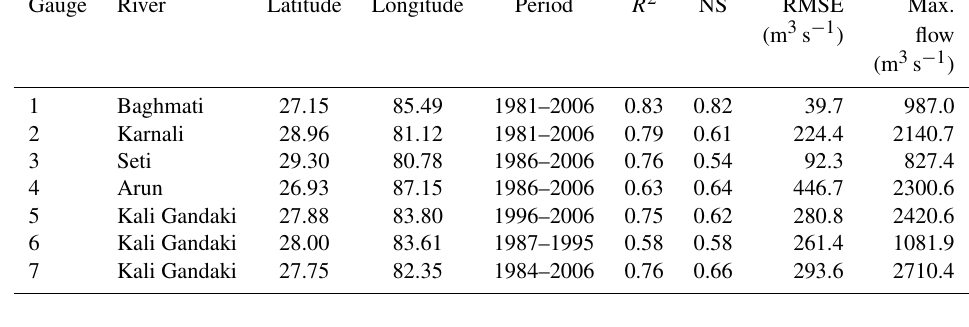
Table 2. Model performance indicators for seven locations in the GRB.